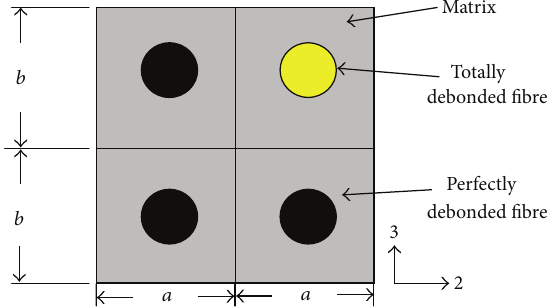
Figure 6: Full model for aligned pattern of composite with one in set of four fibres of unit cell totally debonded.